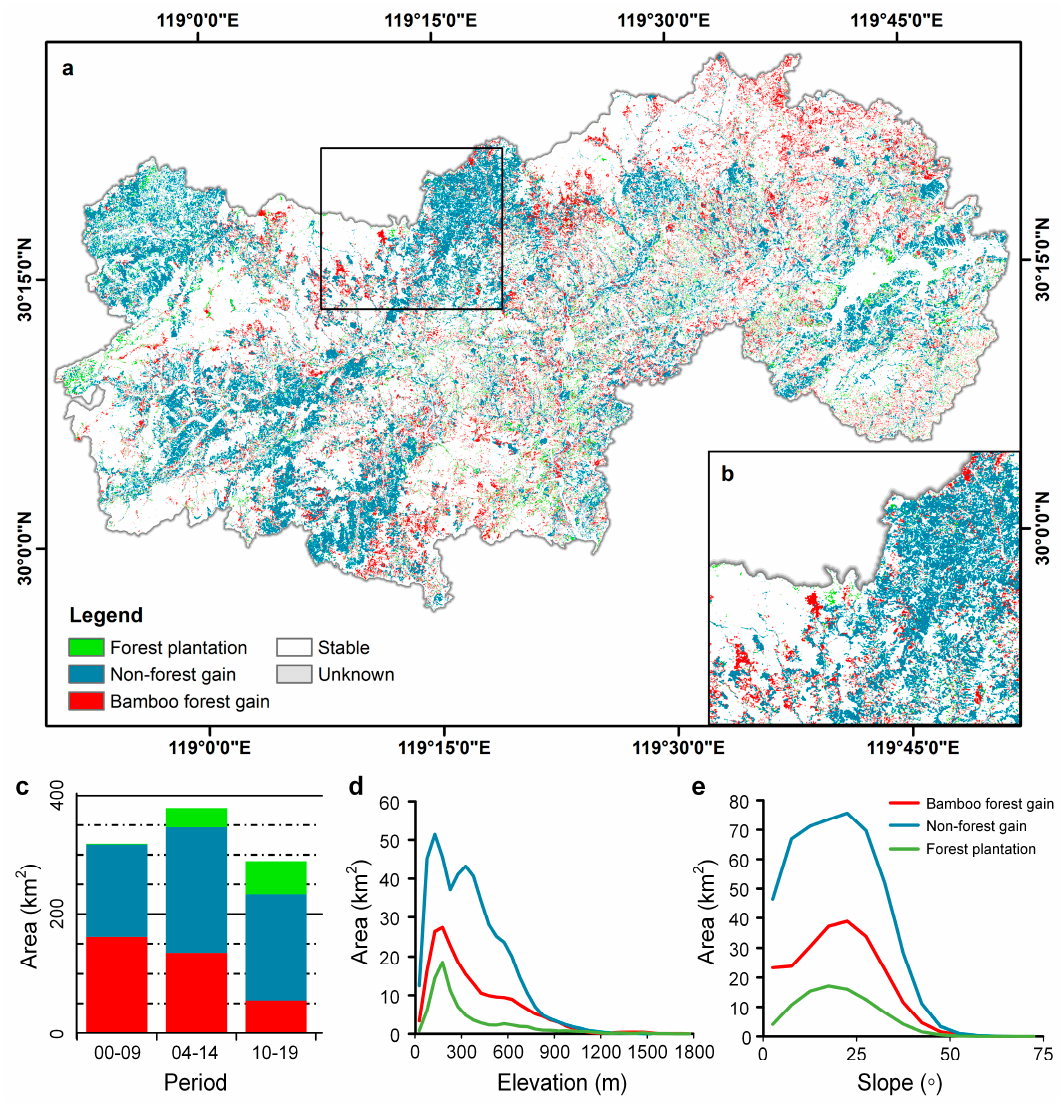
Figure 6. ( a ) Pixel-based historical change map. ( b ) shows a zoom-in view of the region indicated by the black box in Figure 6a (the same as in Figure 5a). ( c ) shows the areas of di ff erent types of changes (bamboo forest gain, non-forest gain and forest plantation) in the di ff erent periods. ( d , e ) show the area dynamics along elevation and slope gradients throughout the whole